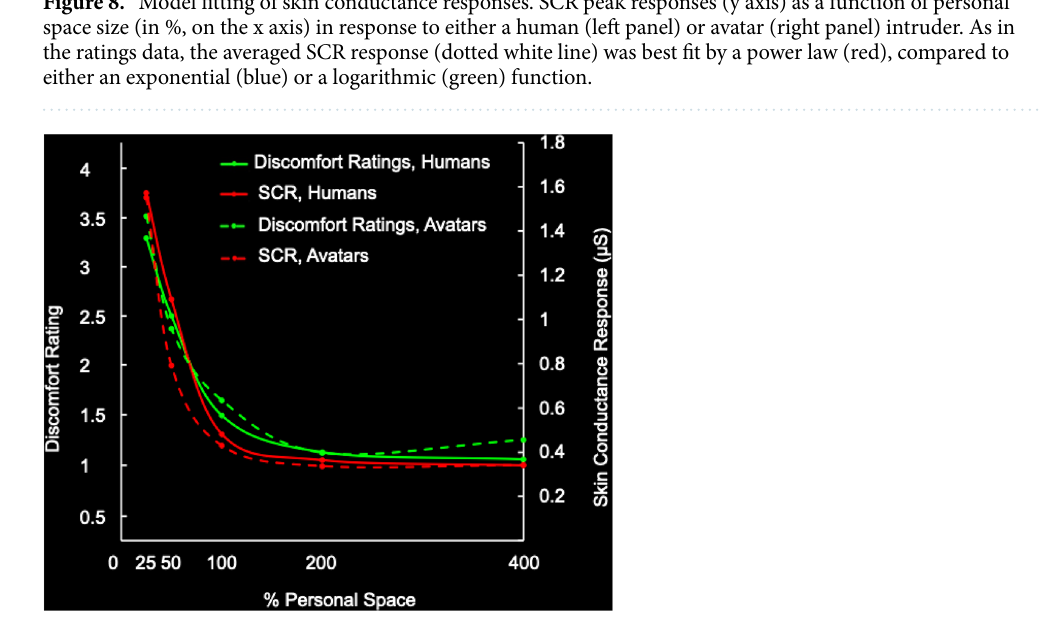
Figure 9. Similarity of discomfort ratings and skin conductance responses, to humans and avatars. The discomfort ratings are shown in green and the SCRs are shown in red. The ratings and SCRs to humans and avatars are displayed with solid and dashed lines, respectively. The minimum rating was 1, so the baseline values (further than the averaged personal space, e.g. at 200% and 400%) was near (but slightly above) 1. In the SCR measurements, the baseline values averaged near 0.4 microSiemens. Both the rating and SCR scales are linear. The scaling of ratings to SCR was otherwise